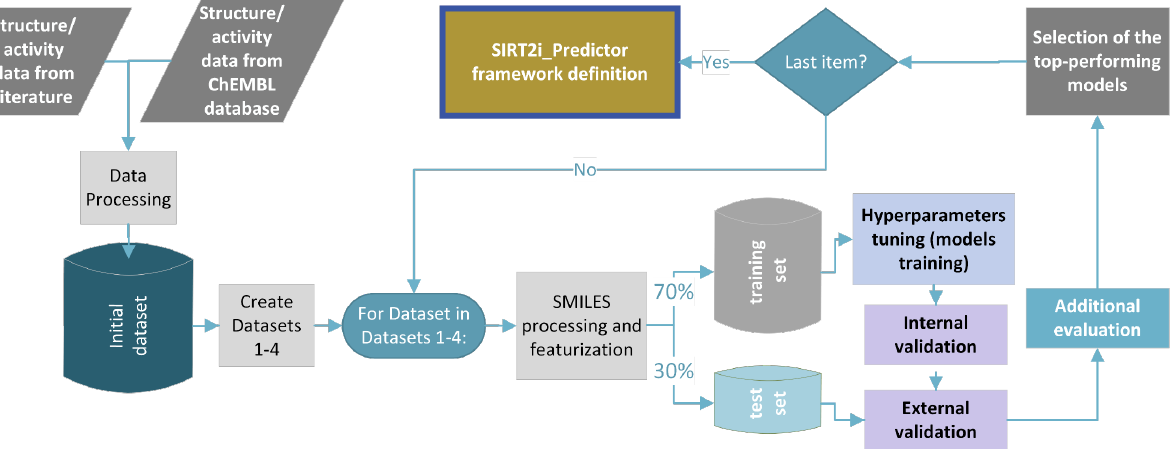
Figure 3. Overall design of the protocol used for generation and validation of the ML models. Table 1. Description of the datasets.